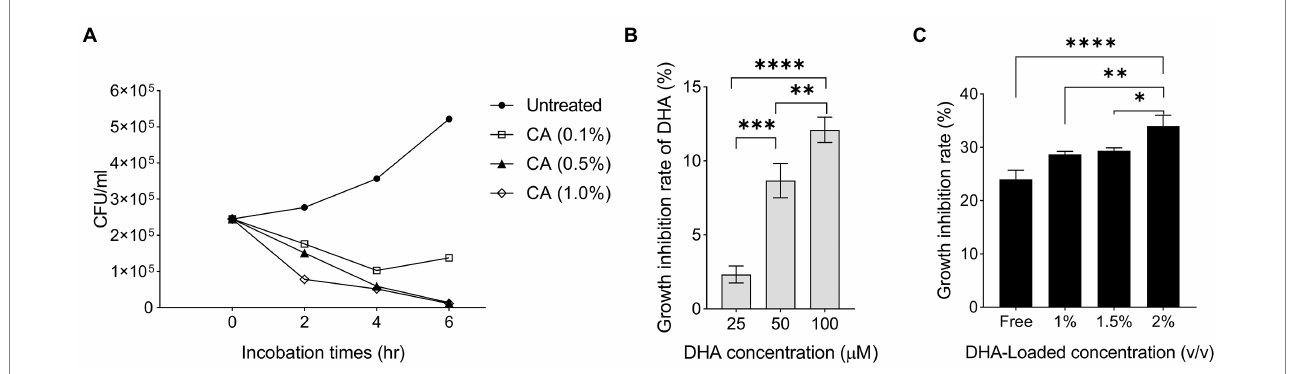
FIGURE 2 The antibacterial activity of DHA and chitosan alone and in combination. (A) The growth inhibition rate of CA NPs with different concentrations of chitosan (0.1, 0.5, and 1.0%). (B) The antibacterial activity of DHA with different concentrations (25, 50 and 100 μ M). (C) The antibacterial activity of DHA -loaded NPs at different loaded concentrations of DHA (CA 0.1%, DHA 1, 1.5 and 2%).